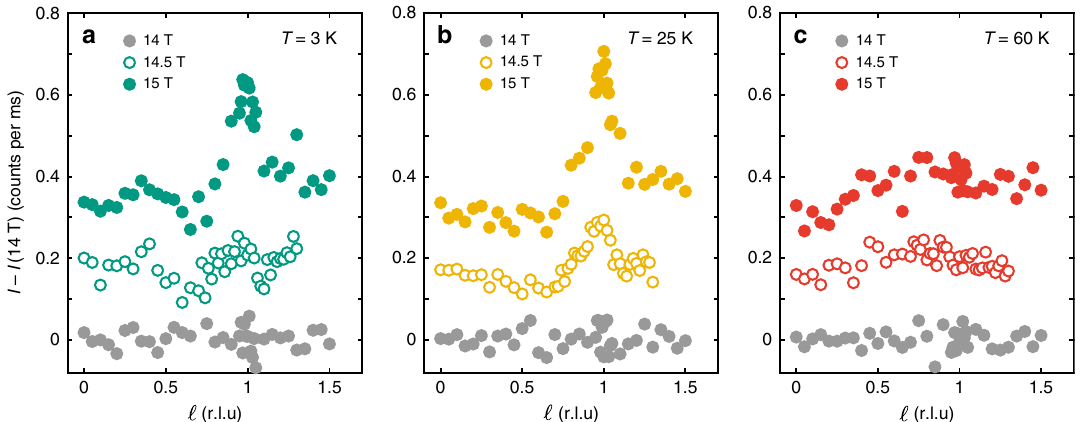
Fig. 4 Temperature and fi eld dependence of in- and out-of-plane diffraction intensities. a – c ℓ -dependent diffraction intensity after subtracting the Gaussian fi tted B = 14 T pro fi les at temperatures and magnetic fi elds as indicated. In this fashion, the relative fi eld effects above 14 T are extracted. Raw 14 T ℓ -scans are shown in Supplementary Fig. 2. Data at different fi elds have been given an arbitrary vertical shift for the sake of presentation. Source data are provided as a Source Data fi